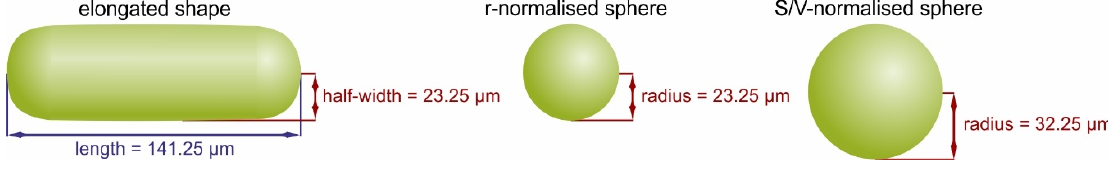
Figure 7. A comparison of the modelled crystal geometries.